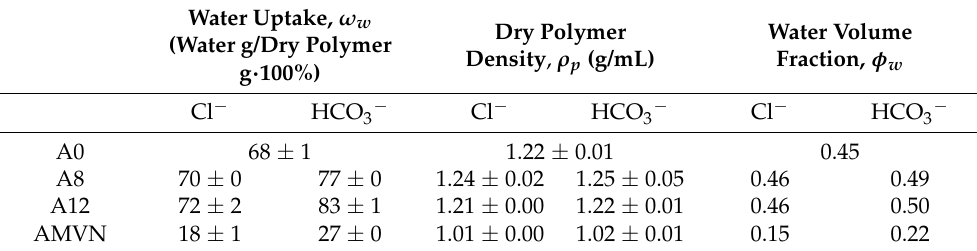
Table 2. Water uptake, dry polymer density and water volume fraction of all films. Water Uptake, ω w Dry Polymer Water Volume (Water g/Dry Polymer Density , ρ p (g/mL) Fraction, φ w g · 100%) Cl − HCO 3 − Cl − HCO 3 − Cl − HCO 3 − A0 68 ± 1 1.22 ± 0.01 0.45 A8 70 ±